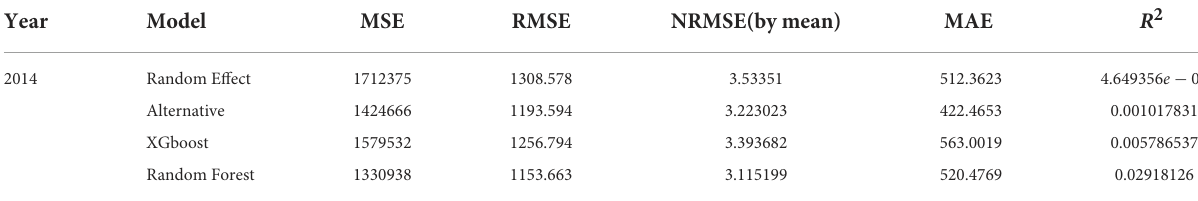
TABLE 8 Fit statistics for each model.